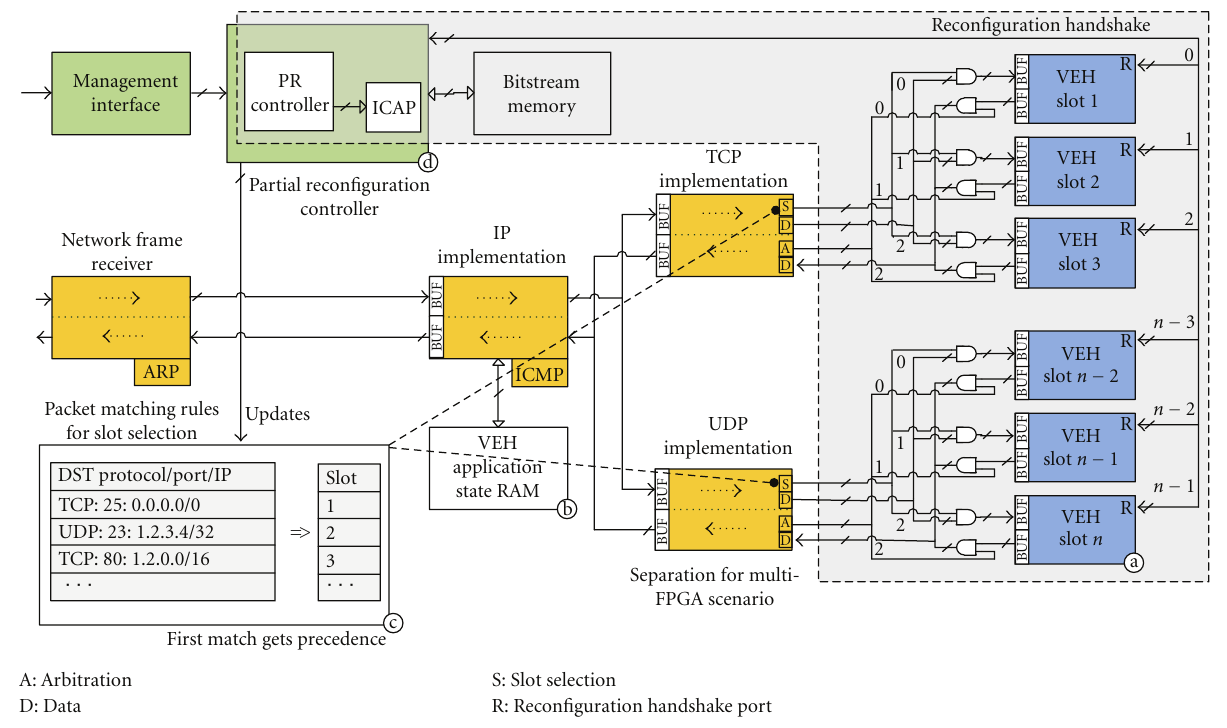
Figure 2: Core architecture of the partially reconfigurable malware collection